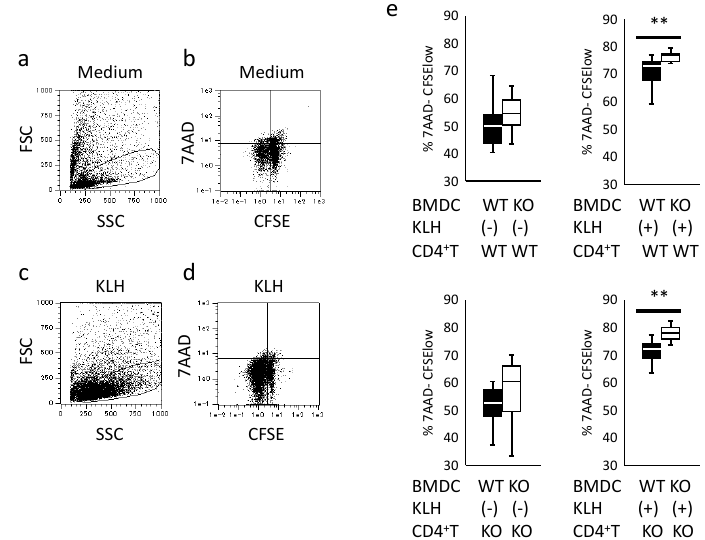
Figure 4. Antigen presentation by BMDC and antigen-immunized CD4 + T-cells proliferation. CD4 + T-cells were isolated from WT and KO mice immunized with keyhole-limpet hemocyanin (KLH). CD4 + T-cells were co-cultured with KLH-stimulated BMDCs, as described in Materials and Methods. ( a ) Gating of CD4 + T-cells cultured with unstimulated KO BMDCs. ( b ) Proliferation of CD4 + T-cells cultured with unstimulated KO BMDCs. ( c ) Gating of CD4 + T-cells cultured with KLH-stimulated KO BMDCs. ( d ) Proliferation of CD4 + T-cells cultured with KLH-stimulated KO BMDCs. ( e ) Proliferation of CD4 + T-cells isolated from KLH-immunized WT and KO mice and co-cultured with unstimulated and KLH-stimulated BMDCs from WT and KO mice. Data are collected the data of two independent experiments each involving eight mice (WT n = 4, KO n = 4) analyzed by Student’s t test. ** p < 0.01.